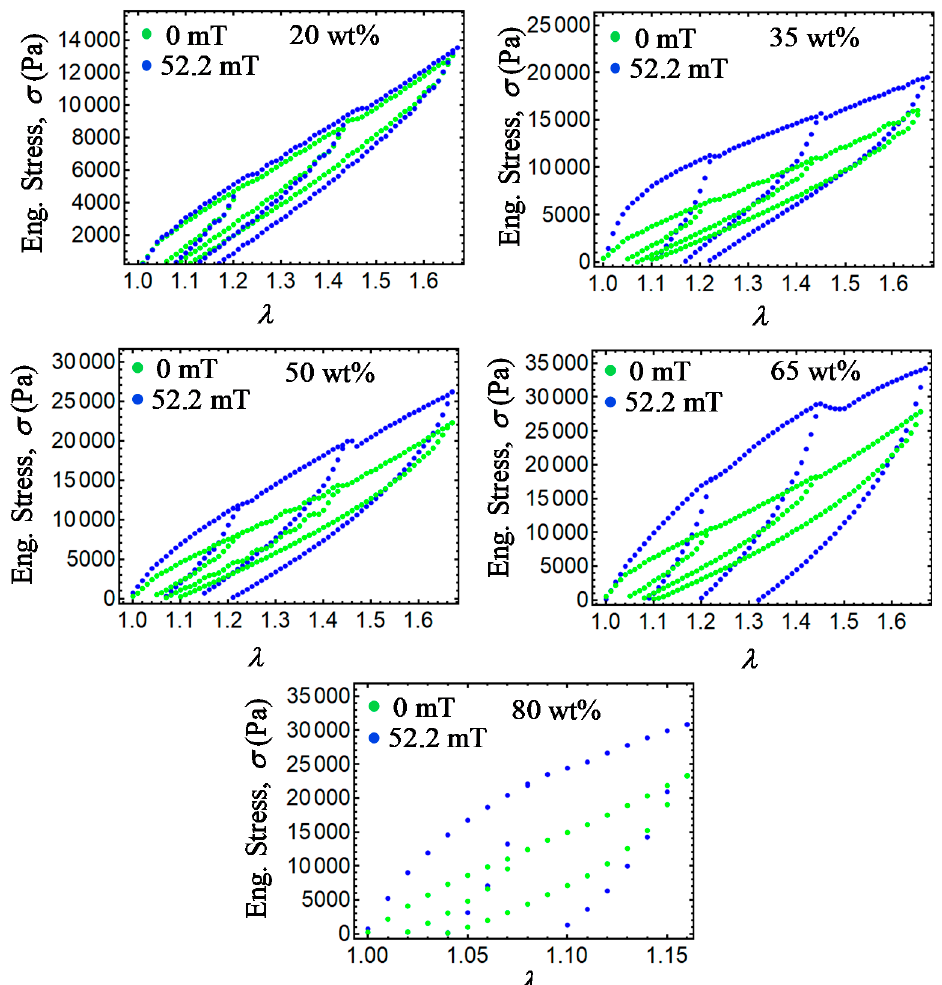
Figure 20. Collected experimental data for anisotropic magnetorheological material samples subjected to loading and unloading cycles with and without the action of a magnetic flux density. Notice that for increasing wt% of CIPs, the material shear moduli, the engineering stress, the dissipation of energy, and residual strains tend to increase.